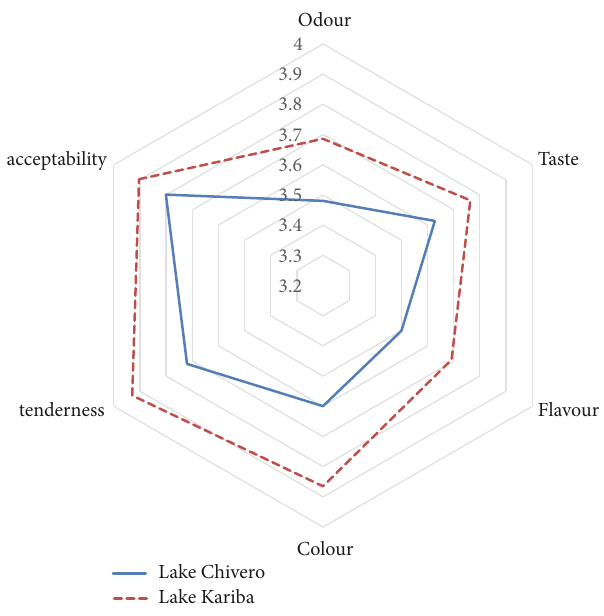
Figure 3: Comparison of sensory parameters for cooked fish from Lake Kariba and Lake